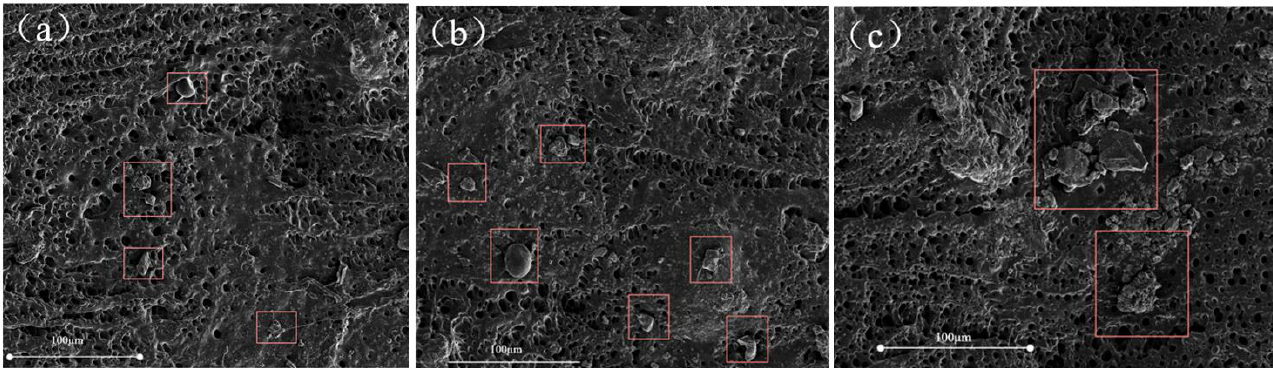
Figure 8. SEM images of composite hydrogels: PAM/HRP-1 ( a ), PAM/HRP-3 ( b ) and PAM/HRP-5 ( c ).